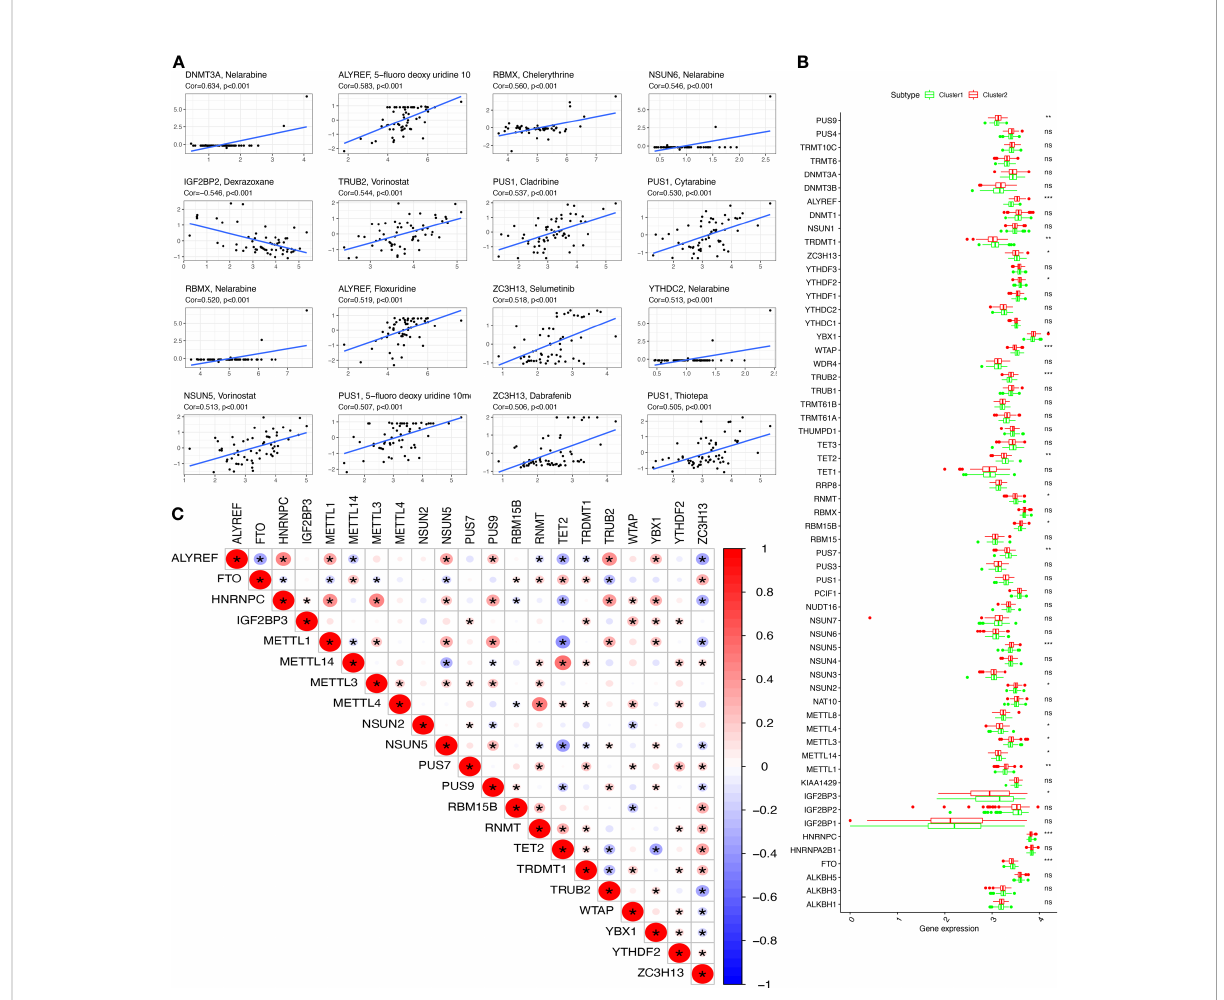
FIGURE 3 The drug sensitivity and DERRGs. (A) The drug sensitivity of DERRGs. (B) DERRGs between two RNA-modi fi cation subtypes. (C) Correlation analysis for DERRGs. *p < 0.05, **p < 0.01, and ***p < 0.001. ns, no signi fi